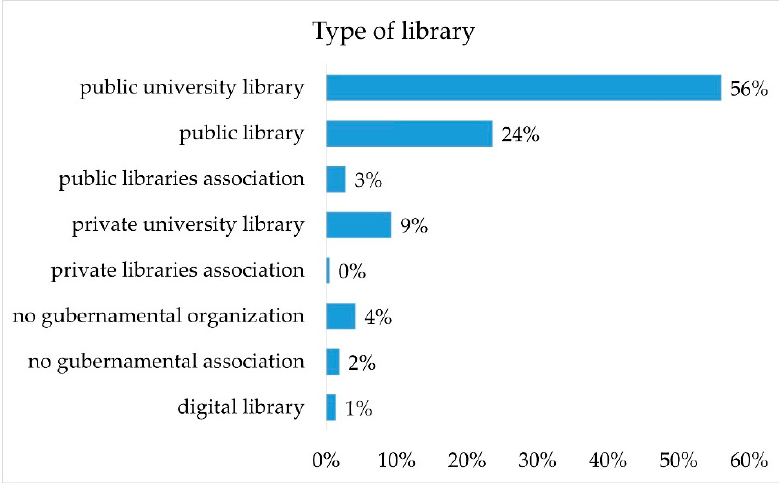
Figure 1. Type of library. Source: prepared by the authors. Eighty-six percent of the practices are an initiative of the library itself; 7% are in cooperation with a public entity/institution; 3% are in cooperation with a media communication; 1% are in cooperation with a private institution; and the remaining 3% represent public and private institutional cooperation.